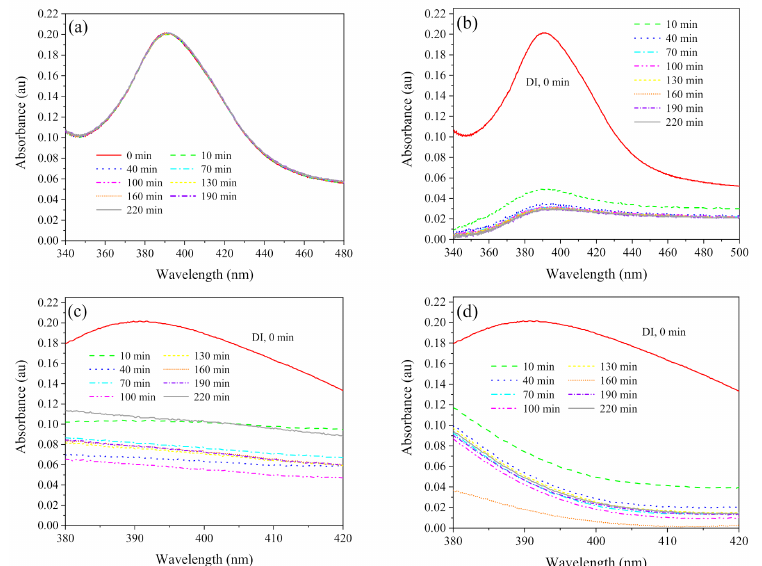
Figure 4. The effect of exposure time on the UV − vis spectra changes after exposing cit − AgNPs (50 × dilution, 1.7 × 10 10 particles ml − 1 , 1.68 mg L − 1 ) in DI ( a ), SW ( b ), DI with sludge ( c ), and SW with sludge ( d ), respectively. Notes: pH and IS in SW was 8.7 and 100 mM, respectively. HA in sludge was 42 mg L − 1